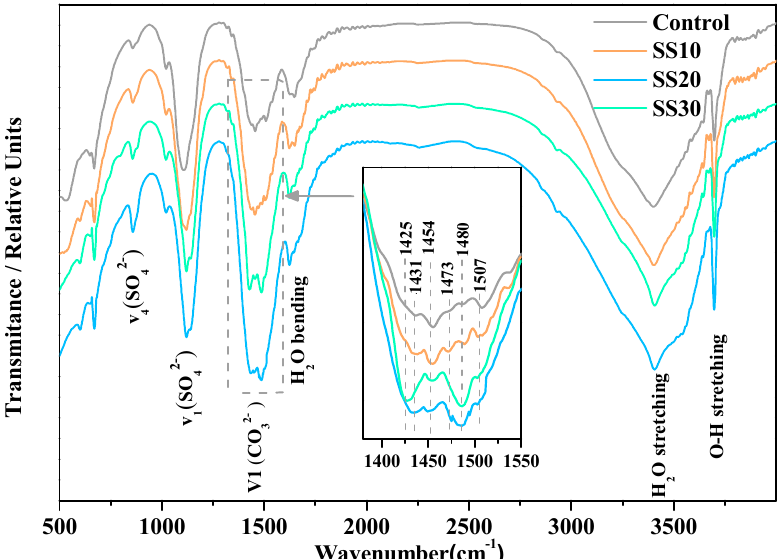
Figure 9. FTIR spectra of the control, SS10, SS20, and SS30 with CO 2 treatment after 28 days curing.